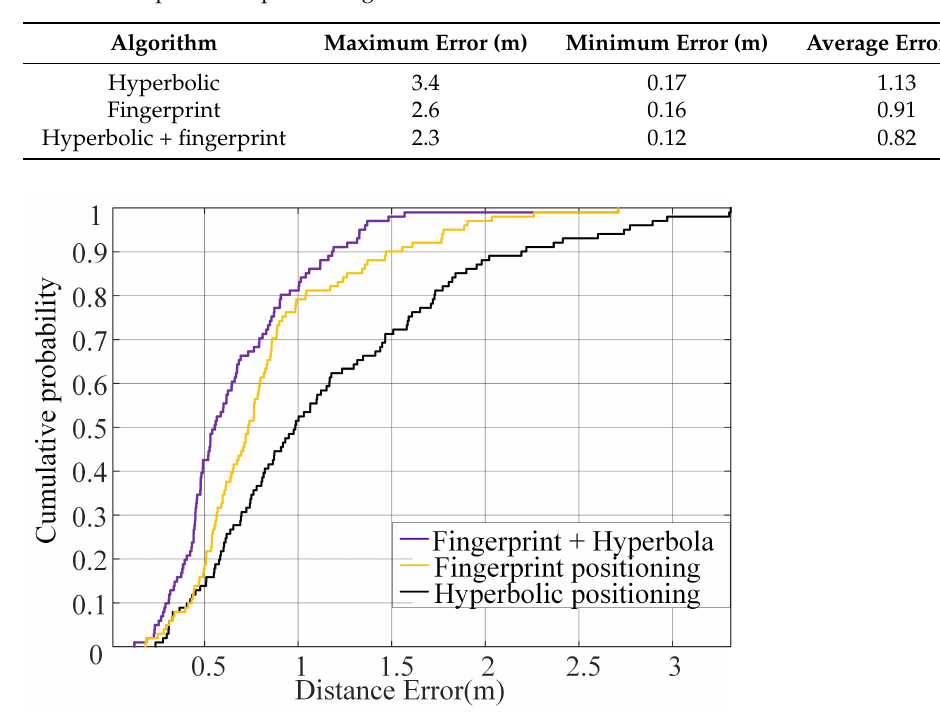
Table 3. Comparison of positioning errors.